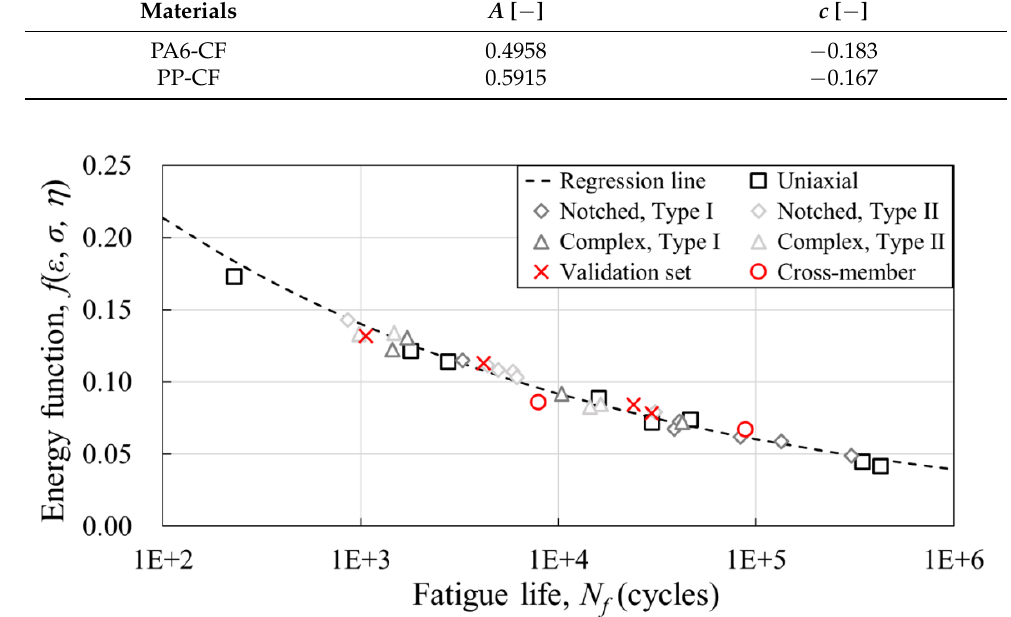
Figure 17. Energy function vs. fatigue life graph with regression line of the PA6-CF (log-linear scale).